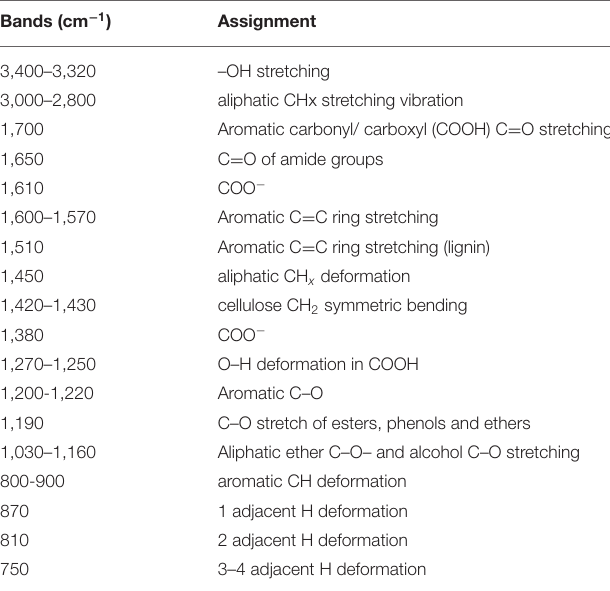
TABLE 3 | Assignment of Infra-Red peaks for analysis of FTIR spectra (From Ascough et al., 2011b, assignments after Guo and Bustin, 1998; Bustin and Guo, 1999; Benites et al., 2005; Trompowsky et al.,